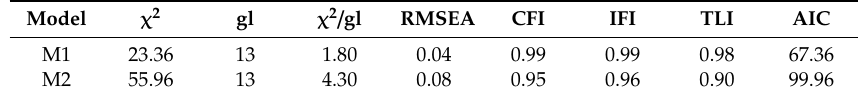
Table 2. Fit indices for structural equation